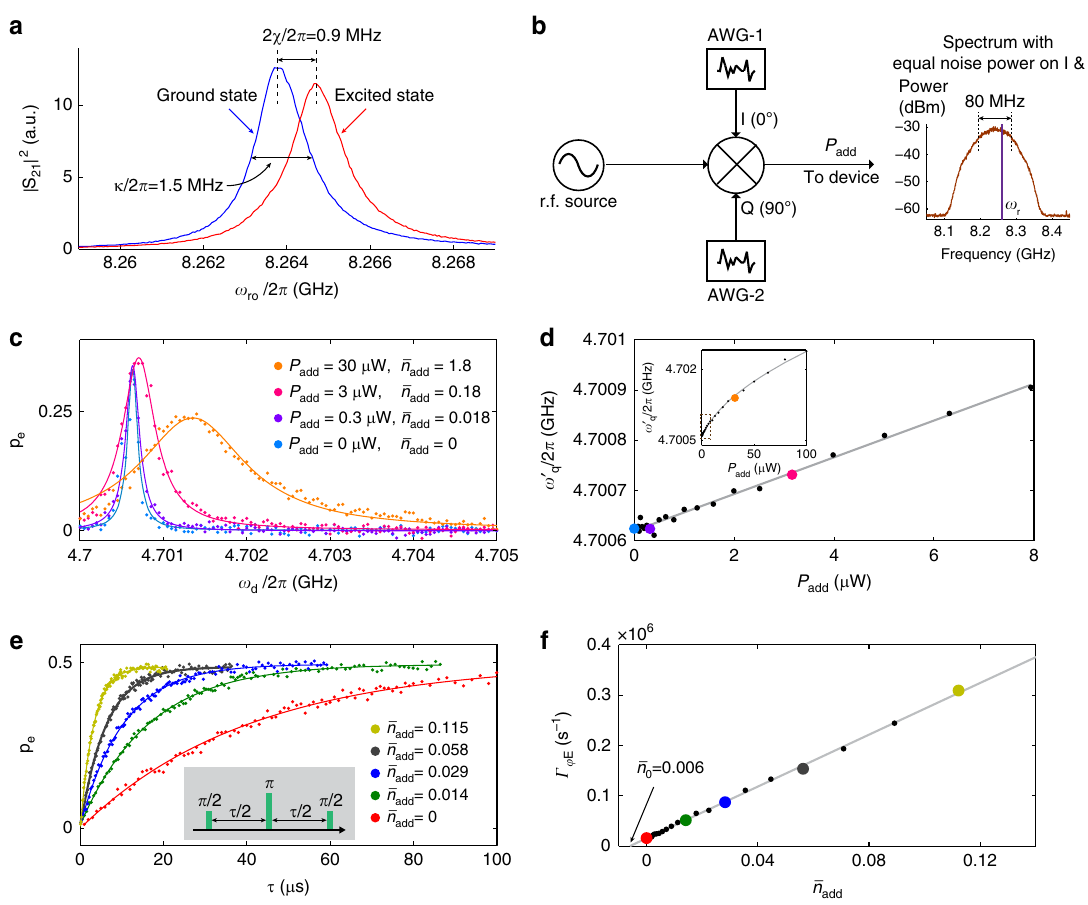
Figure 5 | Calibration of engineered noise. ( a ) Resonator transmission spectra measured with the qubit prepared in the ground and excited states. In contrast to typical transmon qubits with o q o o r , an excited-state C-shunt flux qubit shifts the resonator to higher frequencies because of interactions with higher-level qubit transitions. ( b ) Engineered thermal-photon noise source. A coherent tone near the resonator frequency is mixed with white-noise of nominally equal power from two independent arbitrary waveform generators (AWGs) applied to the in-phase (I) and quadrature (Q) ports of the I/Q mixer. The AWG noise bandwidth (80MHz) is much greater than the cavity linewidth, creating effectively a thermal-photon noise source with power P add . ( c ) Qubit spectral line shape (dots) and lorentzian fits (solid lines) for various added noise powers P add . The equivalent photon population (cid:2) n add added to the resonator is derived from d . The blue trace corresponds to no added noise from the source in b . ( d ) Stark-shifted qubit frequency versus applied noise power (dots). Coloured dots correspond to traces in c . Combining the linear fit (solid line) with the first-order dependence of Stark shift on photon population (equation (4)) yields the power-per-added-photon d (cid:2) n add = dP add ¼ 1 = ð 17 m W Þ in the low-power limit. Inset: wider range of applied noise powers; dashed box indicates the range in the main panel. At large photon populations (cid:2) n add 4 1 ð Þ the frequency shift becomes nonlinear, following equation 43 in ref. 40 (solid line). ( e ) Spin-echo decay (dots) with exponential fit (solid lines) for several values of added photons. Inset: spin-echo pulse sequence. ( f ) Spin-echo pure-dephasing rate (echo decay rate without the T 1 contribution) plotted versus injected photon population (dots). The linear fit (solid line) has slope d G j E = d (cid:2) n add ¼ 2 : 6 (cid:4) 10 6 s (cid:5) 1 , in agreement with the value of 2.5 (cid:4) 10 6 s (cid:5) 1 calculated from equation (5). The intercept indicates a residual photon population (cid:2) n 0 ¼ 0 : 006 in the